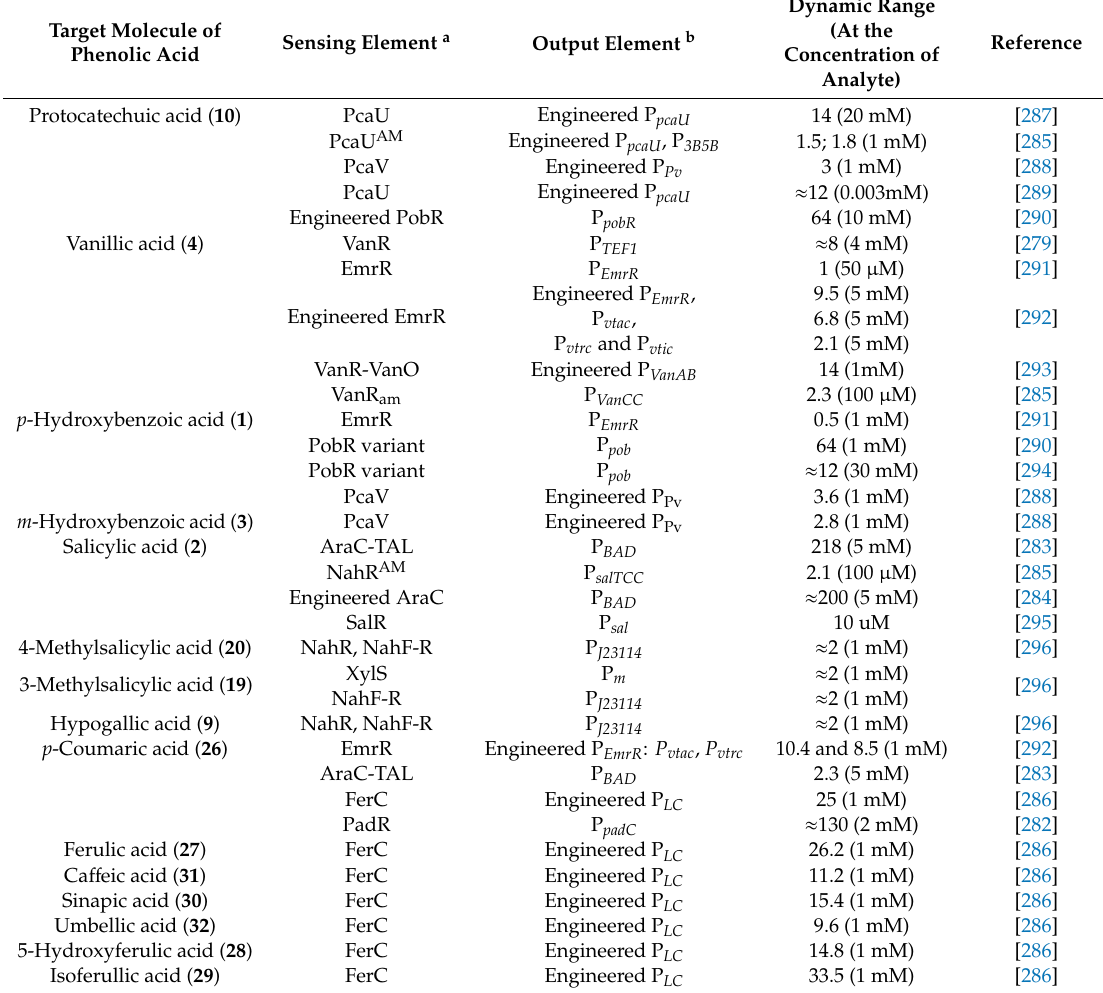
Table 6. Transcription factor-based microbial biosensors for phenolic